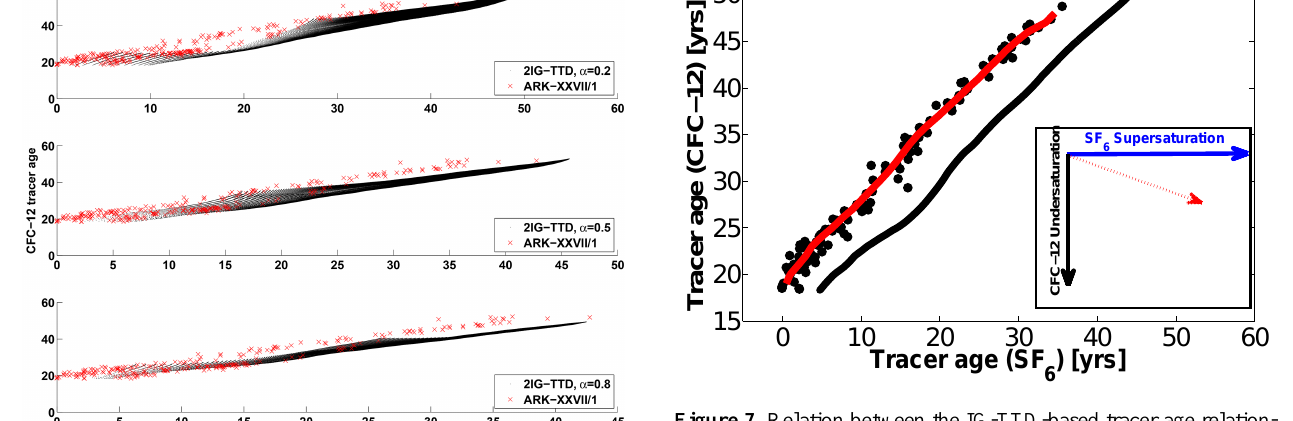
Figure 7. Relation between the IG-TTD-based tracer age relation- ship of the unity ratio (black line) and the mean tracer age rela- tionship of the upper set of the field data (red line). The shape of both curves indicates similarities between the modeled and field data. The difference can be explained by undersaturation of CFC-12 and/or supersaturation of SF 6 (see